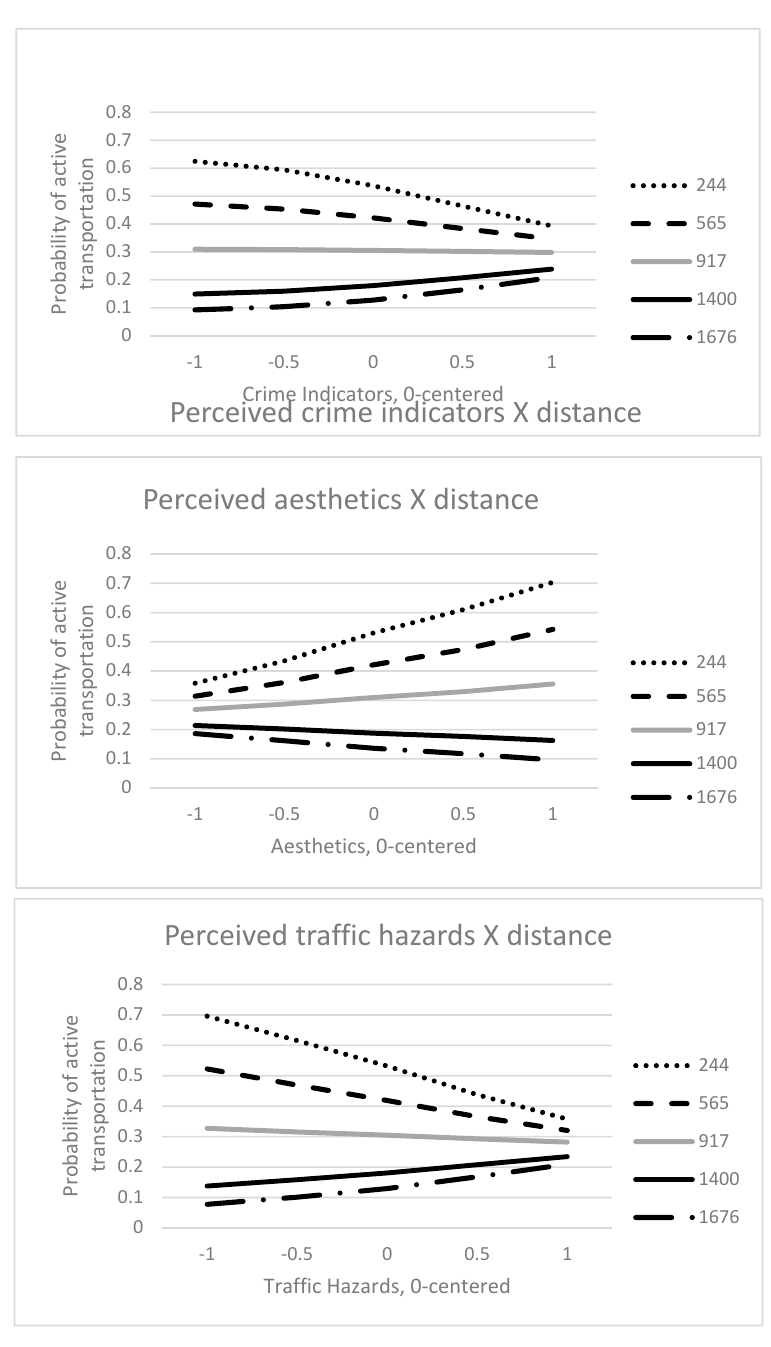
Figure 1. Plots of interactions between perceived walkability scales and distance from the complete street. Note . Legend represents distance from the complete street in meters.